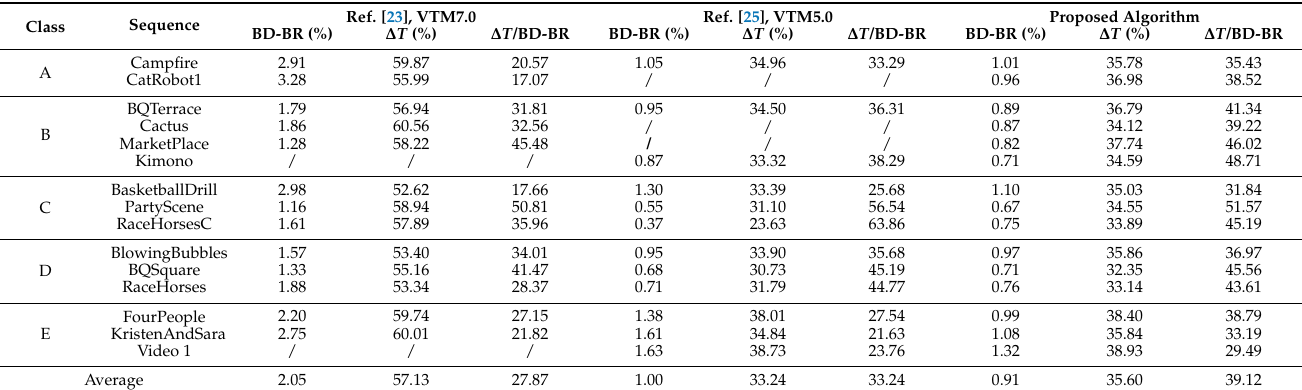
Table 3. Coding performance of the proposed